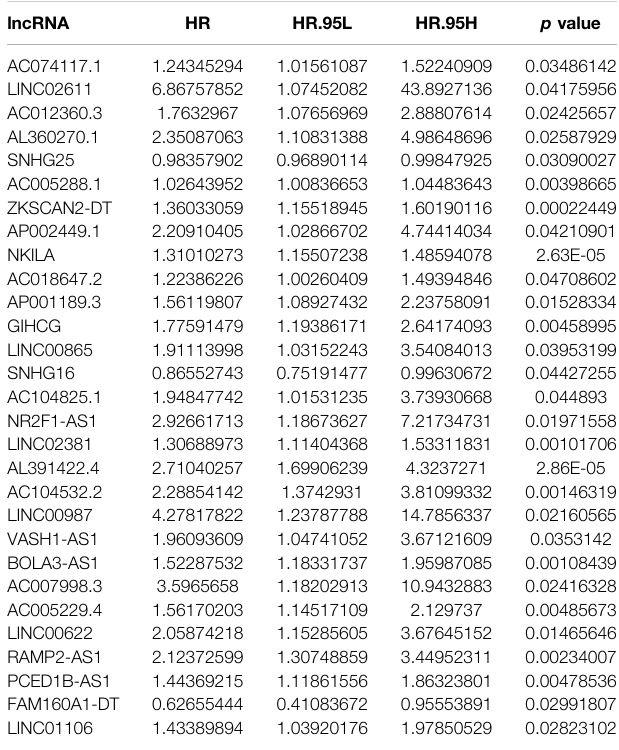
TABLE 2 | Detailed information on the 29 m6A-related lncRNAs.